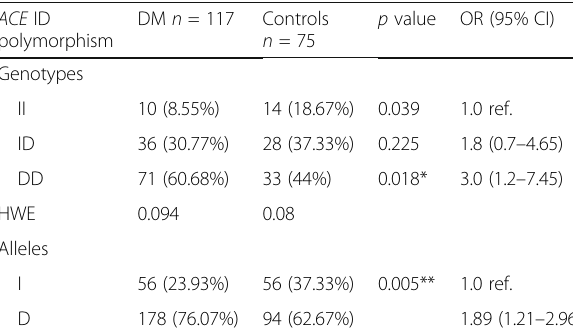
Table 3 Frequency of different genotypes and alleles of the ACE ID polymorphism in patients with diabetes and controls